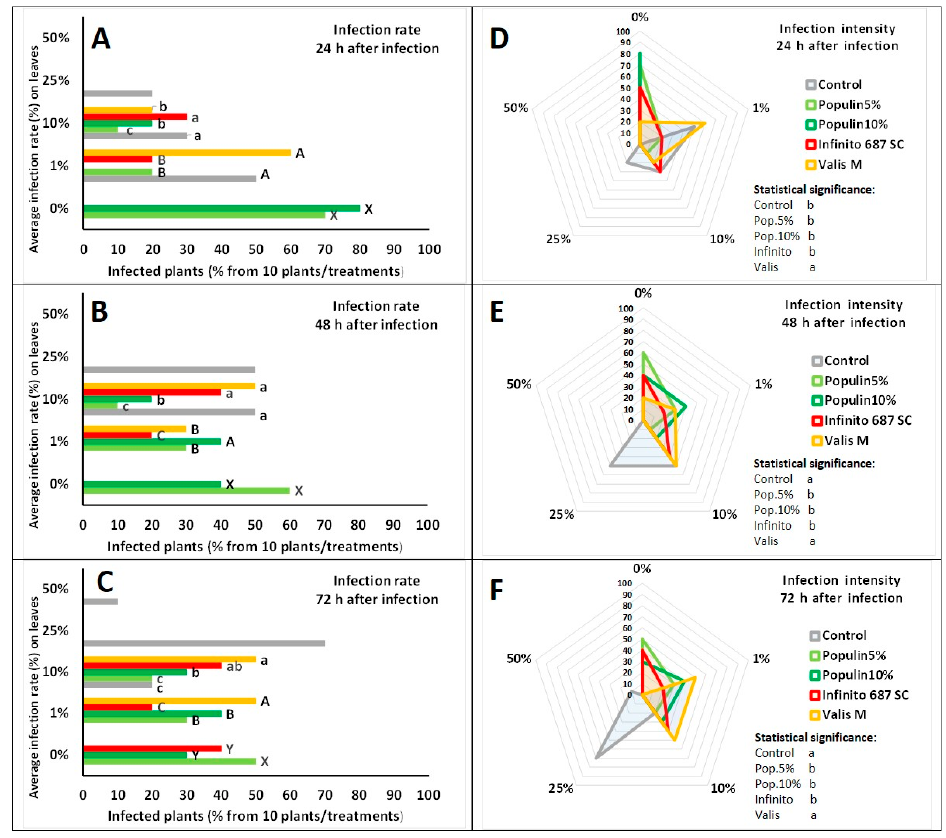
Figure 3. Infection rate after 24 ( A ), 48 ( B ) and 72 h ( C ), and infection intensity after 24 ( D ), 48 ( E ) and 72 h ( F ) of late blight strain M16 under field conditions. Different letters mean statistically significant differences between treatments at the p ≤ 0.01 level (Mann-Whitney test).